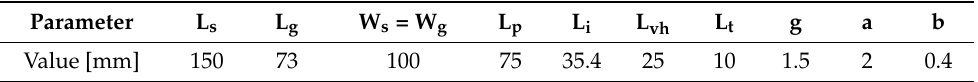
Table 1. Values of the geometrical parameters of the modified octagonal